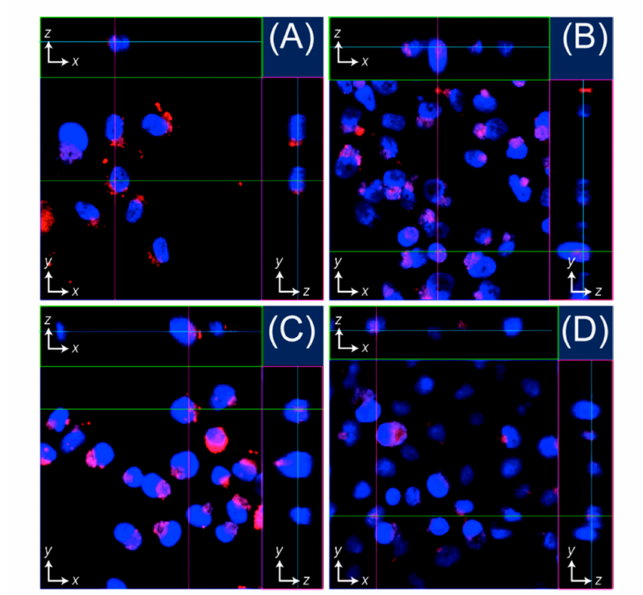
Figure 4. Confocal laser scanning microscopy images (40 × ) of HeLa cells after incubation with ( A ) Entry 1’, ( B ) Entry 2’, ( C ) Entry 3’, and ( D ) Entry 4’ at 37 ◦ C in a 5% CO 2 atmosphere for 4 h ([peptide] = 50 µ M). Red and blue signals indicate fluorescence emissions from 5(6)-carboxytetramethylrhodamine (TMR) and Hoechst 33342,